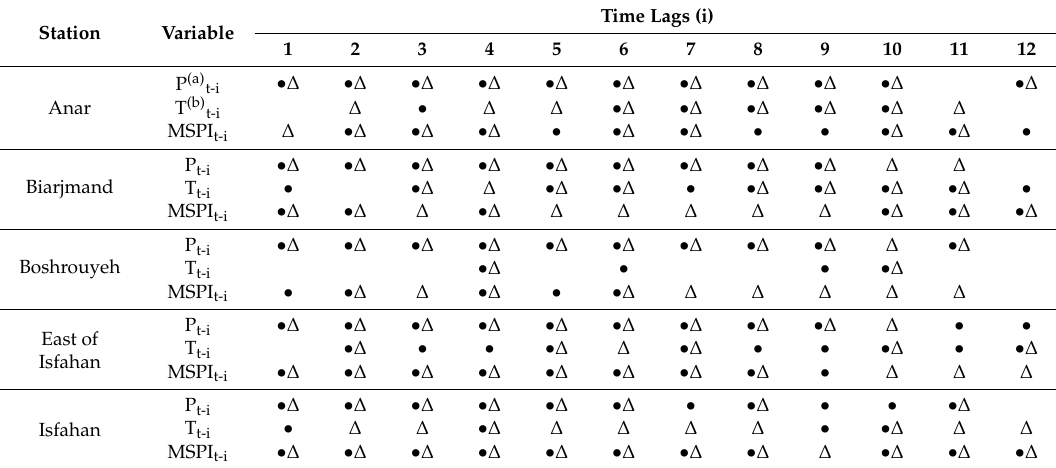
Table 4. Chosen inputs by gamma test ( • ) and entropy theory ( ∆ ) for multivariate standardized precipitation index